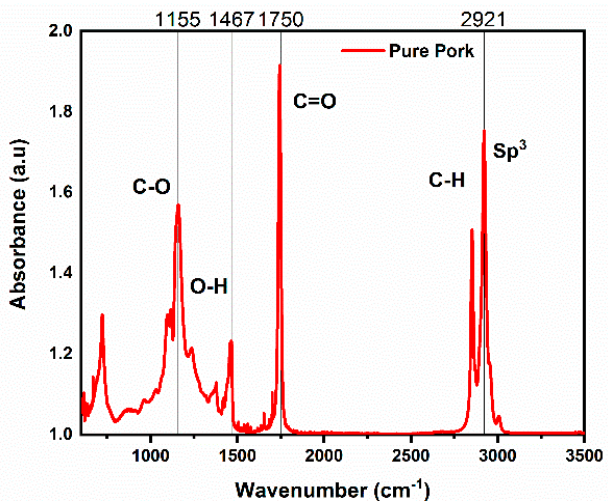
for all species, as indicated in Figure 2, where the change in absorbance values is highly prominent; wavenumbers associated with these two regions are in the spectrum ranges of 1700–1800 cm − 1 for RoD(a) and 2800–3000 cm − 1 for RoD(b) respectively as shown in Figure 3. The FTIR spectra of all the lipids obtained from different species were combined and overlapped.